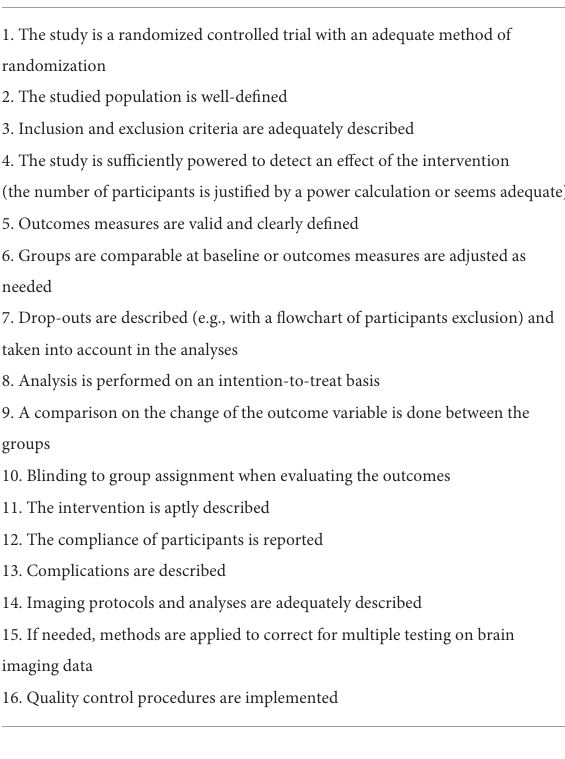
TABLE 1 Notation criteria used to rank studies’